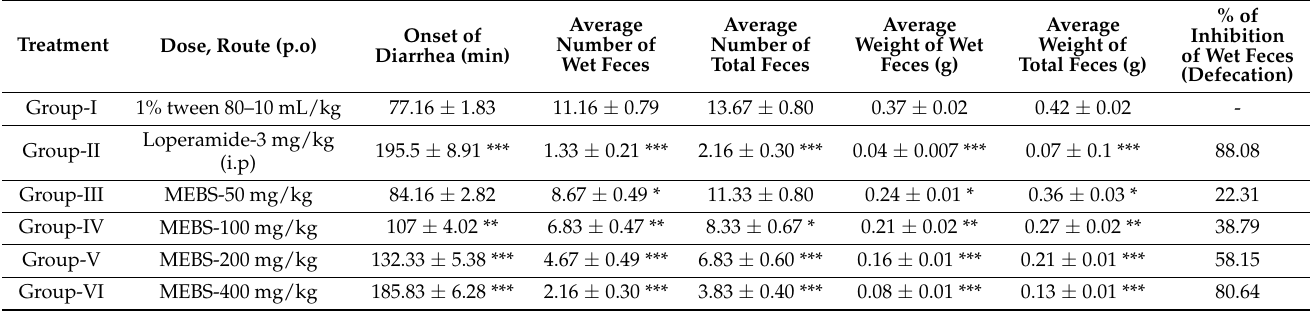
Table 2. Effect of the test samples on castor oil induced diarrhea in